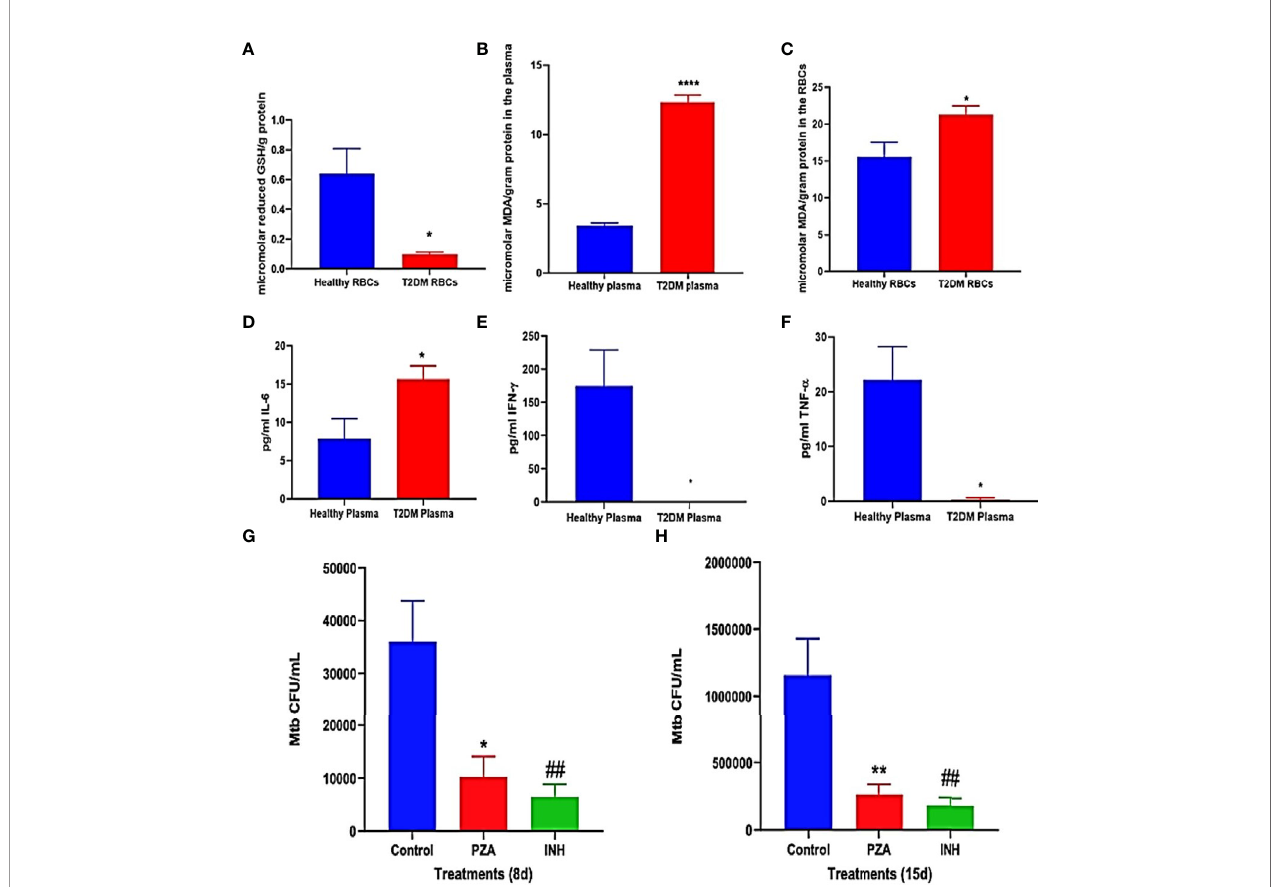
FIGURE 3 | (A – E) Preclinical Findings. Quanti fi cation of reduced GSH (GSH), malondialdehyde (MDA), IL-6, IFN- g , and TNF- a in healthy subjects and individuals with T2DM. Levels of GSH in the RBCs (A) were determined by spectrophotometry using an assay kit from Invitrogen. Levels of malondialdehyde in the plasma (B) and RBCs (C) were measured by spectrophotometry using an assay kit from Invitrogen. IL-6 (D) , IFN- g (E) , and TNF- a (F) levels in the plasma samples isolated from healthy subjects and individuals with type 2 diabetes were determined by ELISA (Invitrogen). (G, H) Survival of M. tb in untreated, PZA-treated, and INH-treated in vitro granulomas generated from PBMCs isolated from individuals with type 2 diabetes. PBMCs isolated from individuals with T2DM were infected in vitro with Erdman strain of M. tb and were either untreated (control), treated in vitro with PZA (5 mg/ml), or INH (0.0125 mg/ml). Granulomas were terminated at 8-days (G) and 15-days (H) post-infection. Cell-free supernatants were collected and stored. Granulomas were lysed with ice-cold PBS. Supernatants and granuloma lysates were plated on 7H11 agar plates containing ADC to determine the survival of M. tb. A p <0.05 is considered signi fi cant indicated by an asterisk (*). (**) indicates a p <.005, (****) indicates p <0.0001, (##) indicates a p